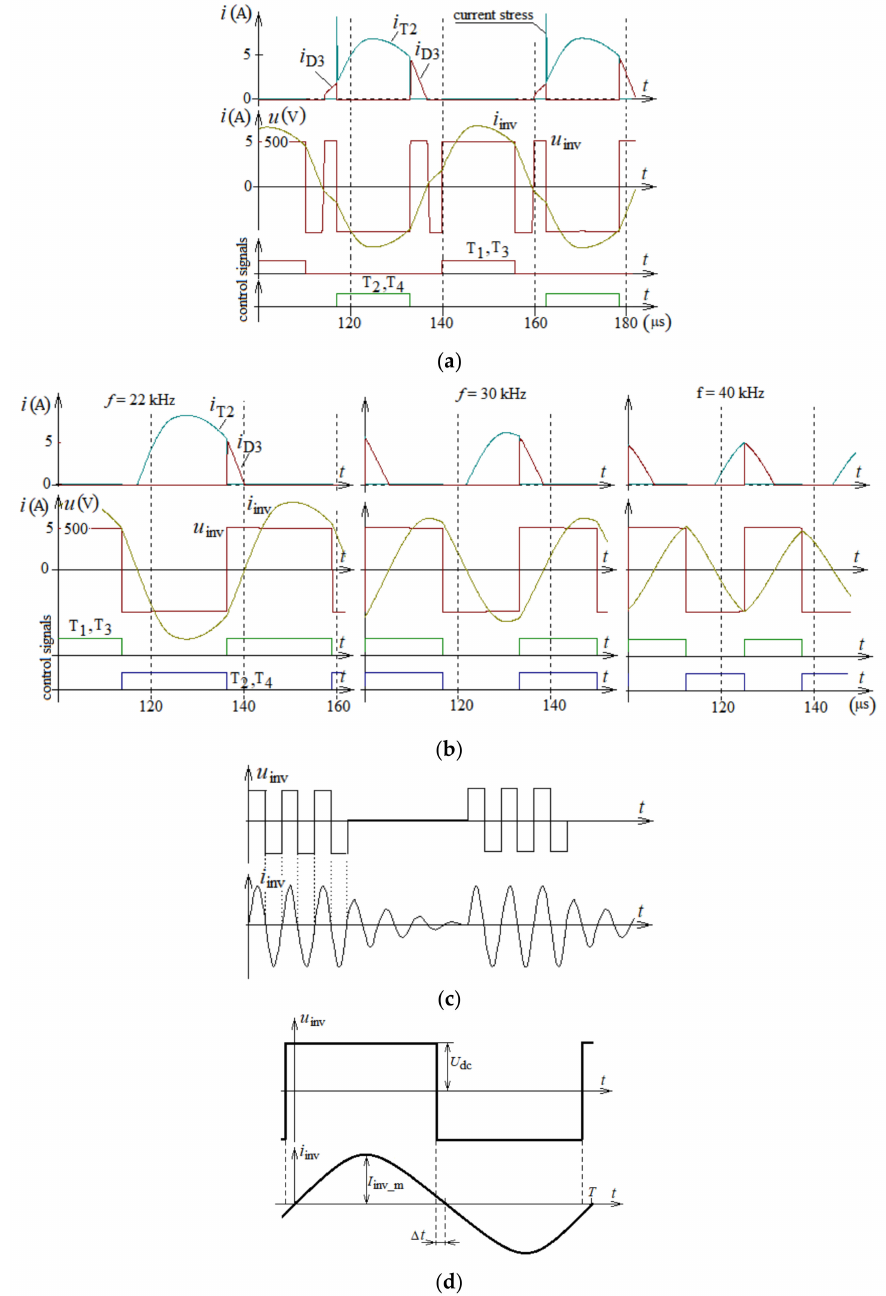
Figure 2. Waveforms of the inverter output voltage and current with di ff erent control methods, reproduced from Przegl ˛ad Elektrotechniczny [35]: ( a ) PWM, ( b ) PFM, ( c ) PDM, ( d ) PAM: i T